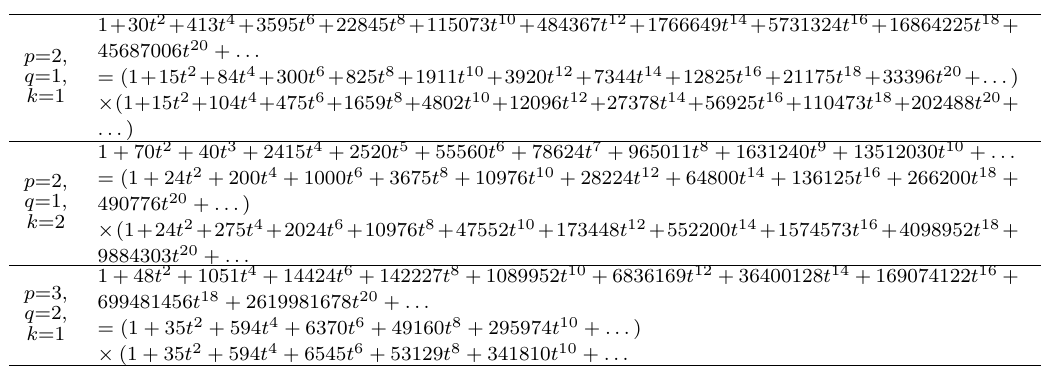
Table 21. Hilbert series results for (4.8). The first line displays the Coulomb branch Hilbert series for (4.8), while the second line displays the factorisation into a product of two identical factors. Each factor agrees with the known Hilbert